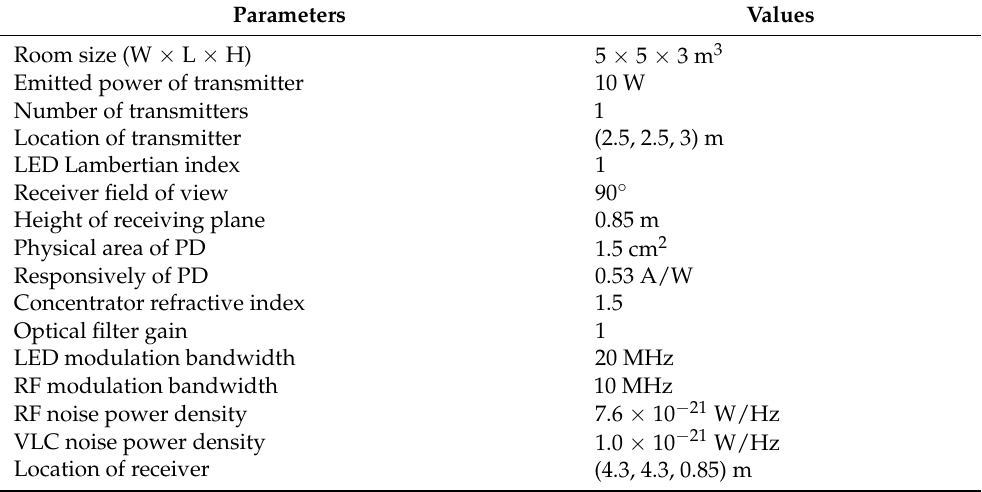
Table 1. Main parameters